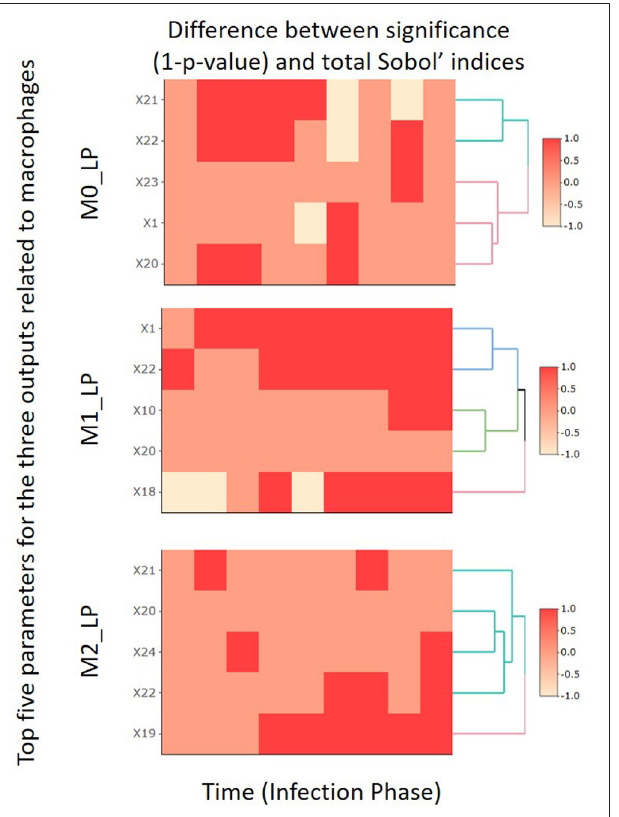
FIGURE 6 | Comparison heatmaps of the PRCC and total indices obtained in the second-stage analysis focusing on the 10 time